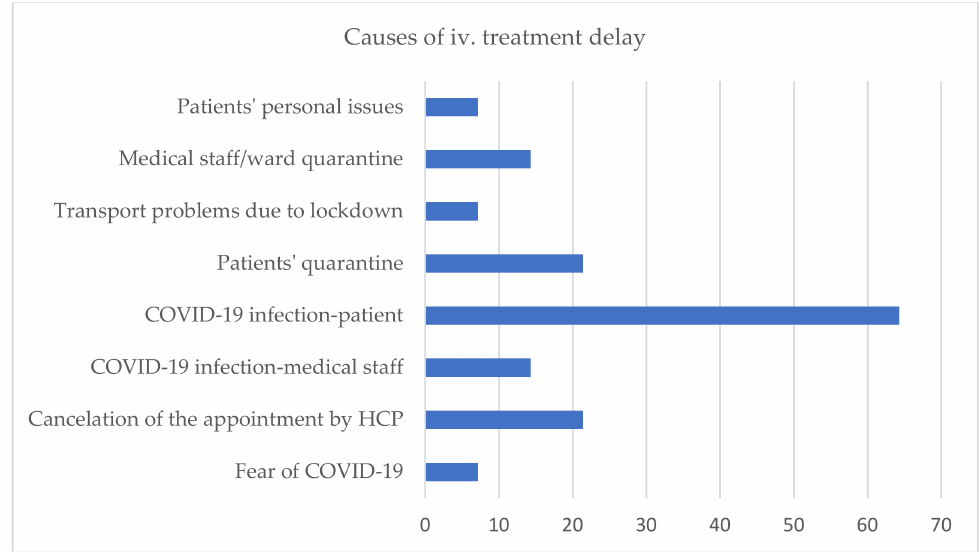
Figure 4. Causes of ERT delay (HCP—health care